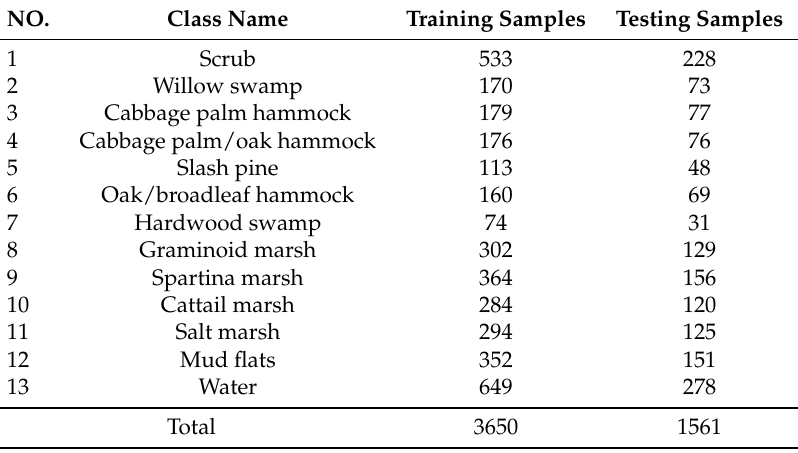
Figure 7. Kennedy Space Center dataset. ( a ) Three-band false-color composite. ( b ) Ground-truth map. Table 3. Samples size for Kennedy Space Center